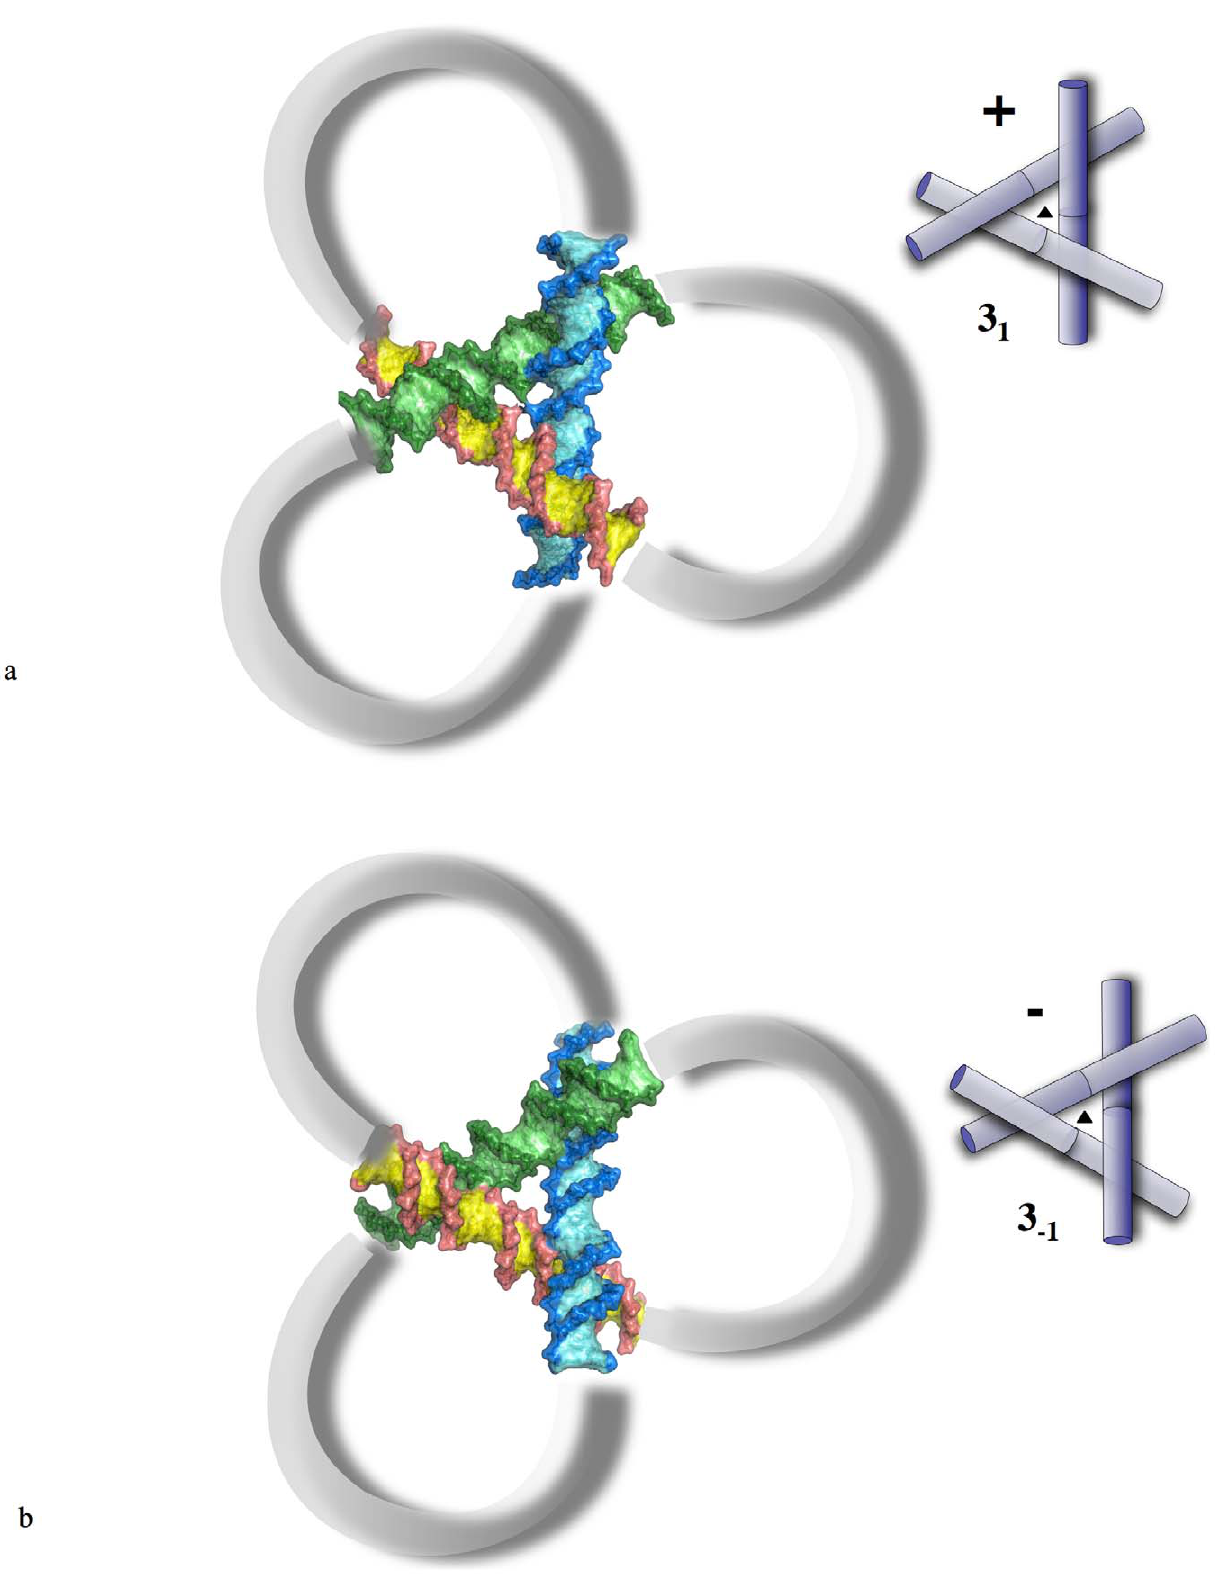
Figure 3. Influence of the helical chirality on the formation of DNA trefoil knots of opposite signs. Motifs produced by the combination of crossovers in the crystal structure of the decamer d(CCGCCGGCGG) (NDB id: BD0015). The loops that connect the arms are for illustration purposes only. The two trefoils alternate along a common 3-fold axis of the unit cell. (a) ( + ) trefoil with groove-backbone intersegmental interaction (3 1 ). (b) ( 2 ) trefoil assembled with groove-groove intersegmental interactions (3 2 1 ). Positive trefoils adopt a significantly more compact structure than negative trefoils.